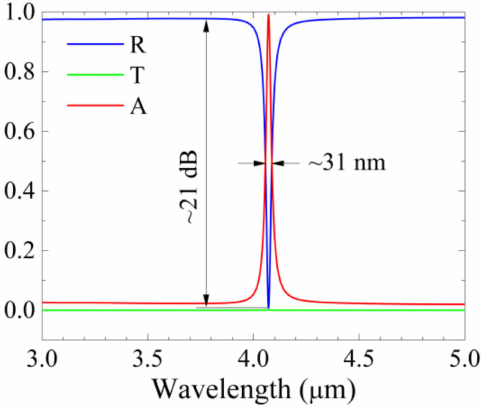
Figure 2. Simulated reflection (R), transmission (T), and absorption (A) spectra at normal